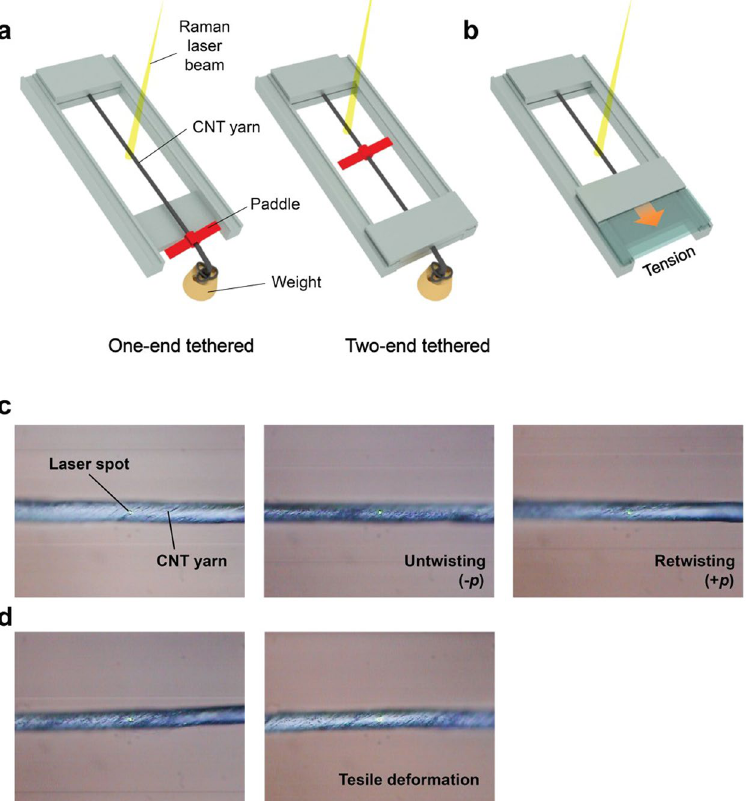
Figure 1. In-situ Raman spectroscopy system to characterize the orientation and deformation of individual CNTs in CNT yarns. ( a , b ) Schematic diagrams of ( a ) torsional and ( b ) tensile devices used for in-situ Raman spectroscopy studies for characterizing the orientation and deformation of individual carbon nanotubes (CNTs) in CNT yarns. ( c , d ) in-situ Raman tests during ( c ) torsional and ( d ) tensile